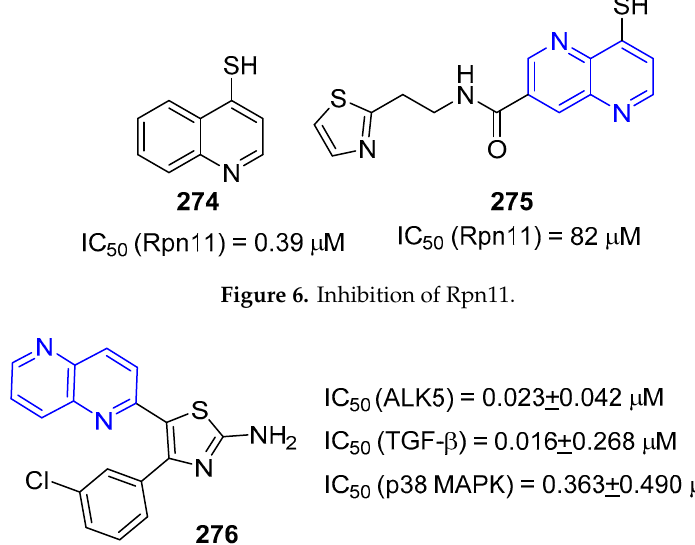
Figure 6. Inhibition of Rpn11.